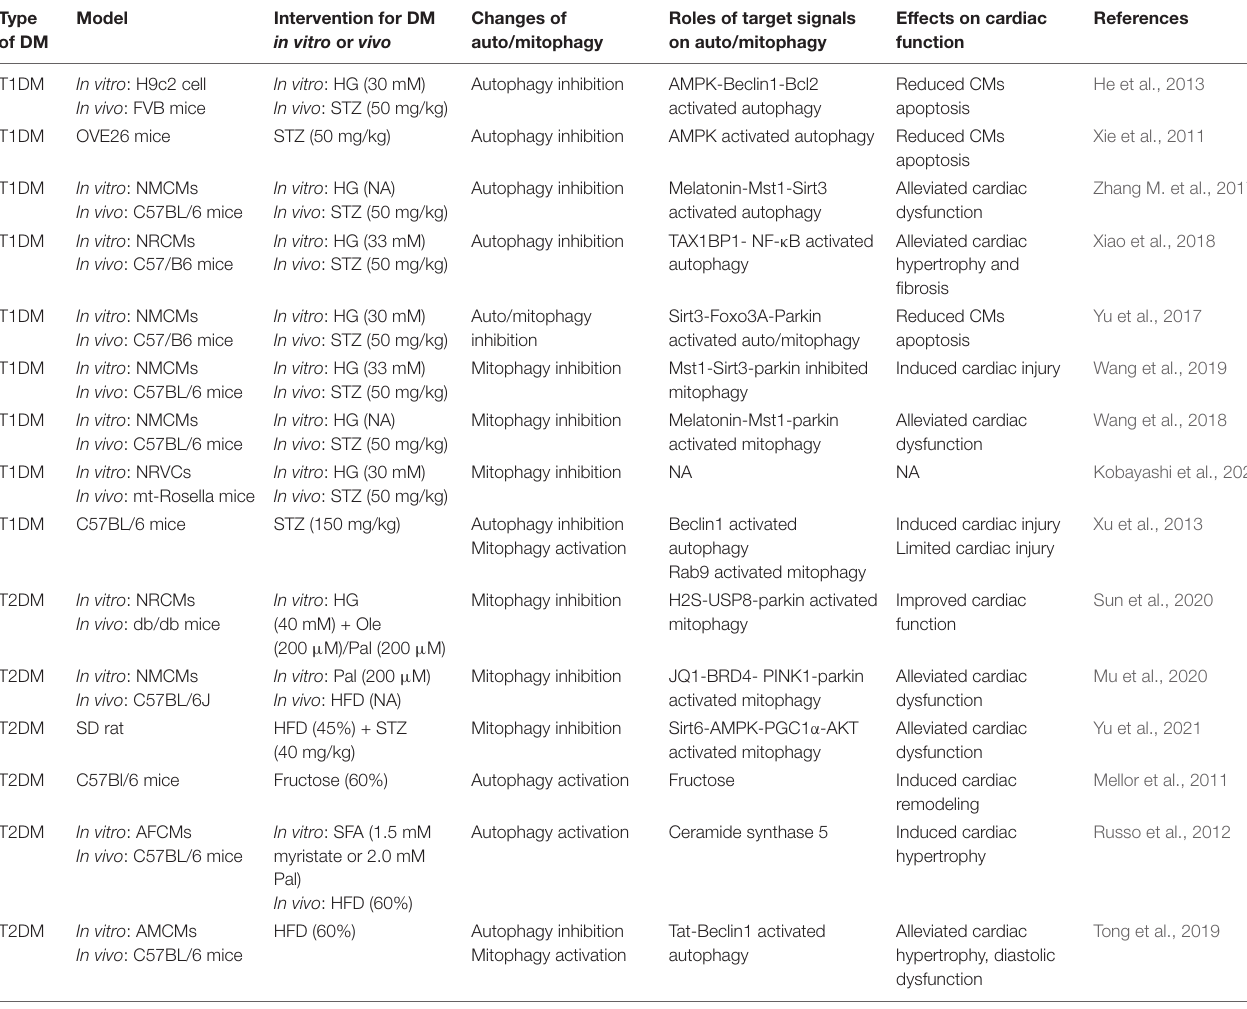
TABLE 1 | The roles of auto/mitophagy in Type 1 DCM and Type 2